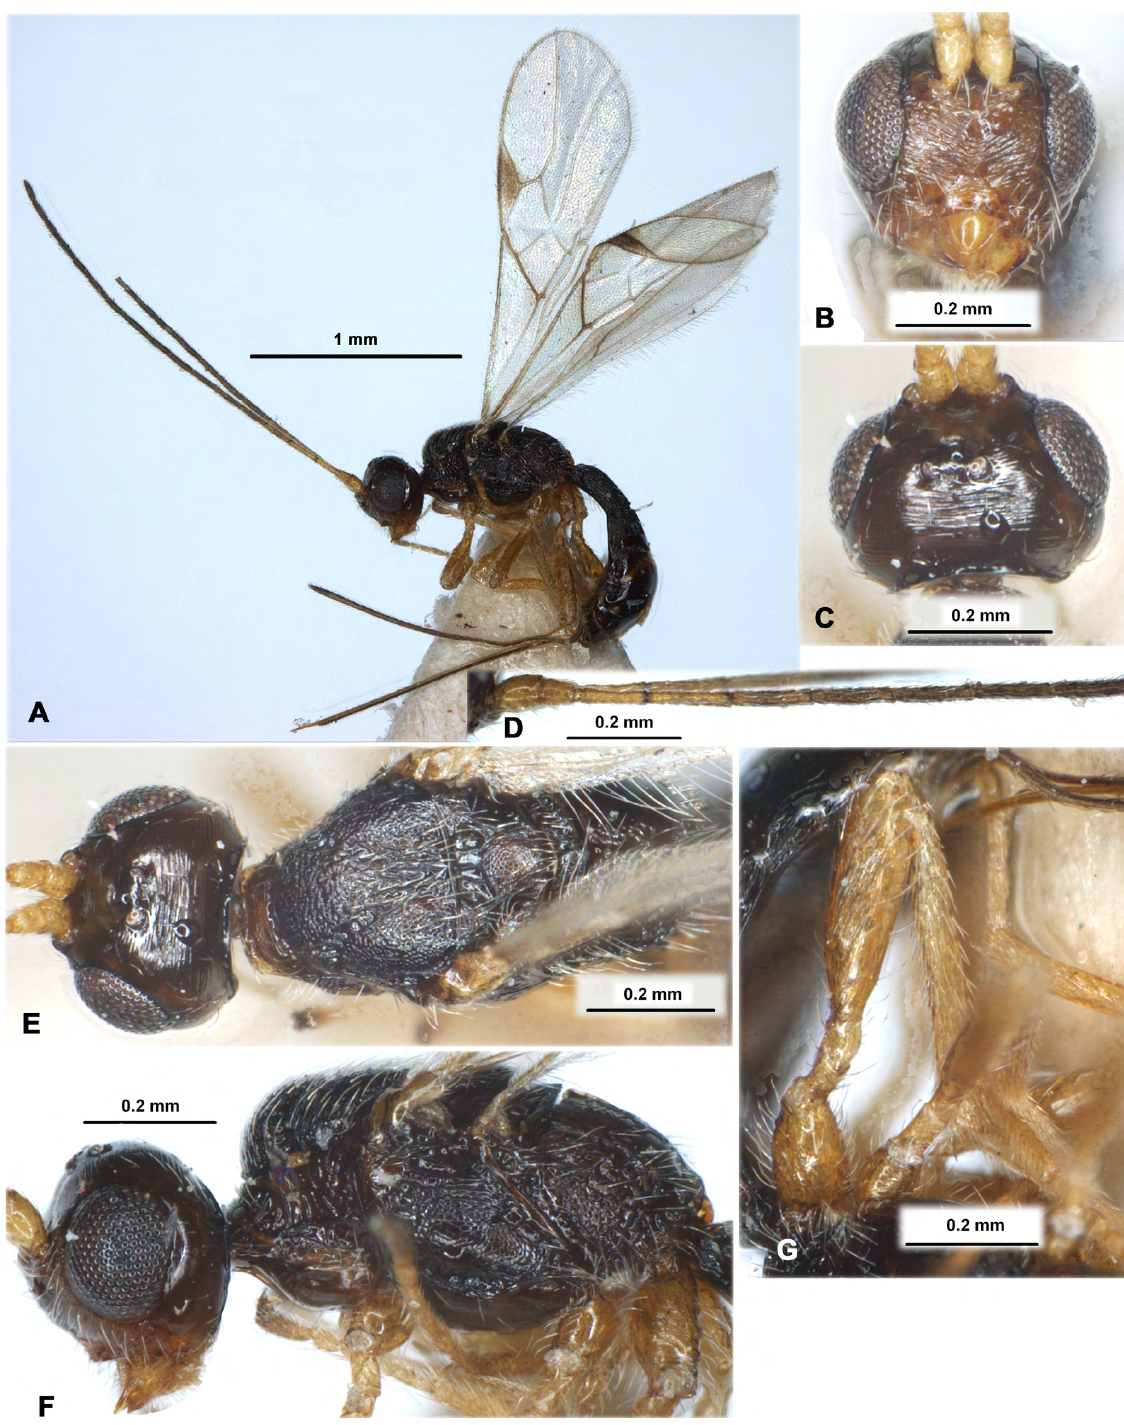
Fig. 49. Rhacontsira heterospiloides (Belokobylskij, 1988), ♀, holotype, ZISP. A . Habitus, lateral view. B . Head, front view. C . Head, dorsal view. D . Basal segments of antenna. E . Head and mesosoma, dorsal view. F . Head and mesosoma, lateral view. G . Hind leg, lateral